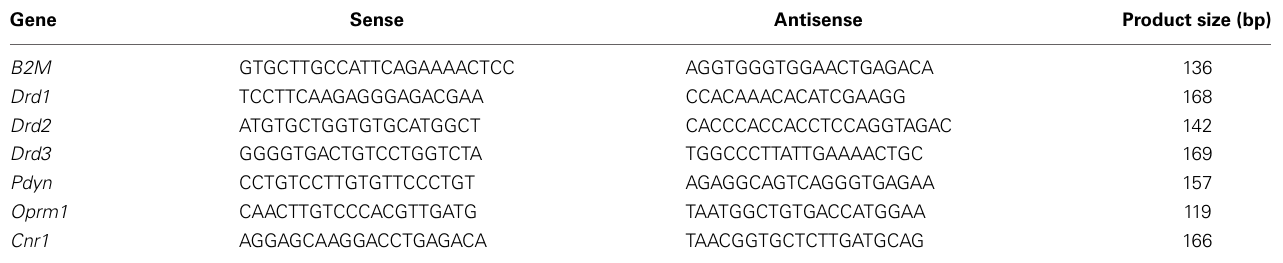
Table 1 | Sense and antisense sequences of oligonucleotide primers used in the qRT-PCR. Gene Sense Antisense Product size (bp) B2M